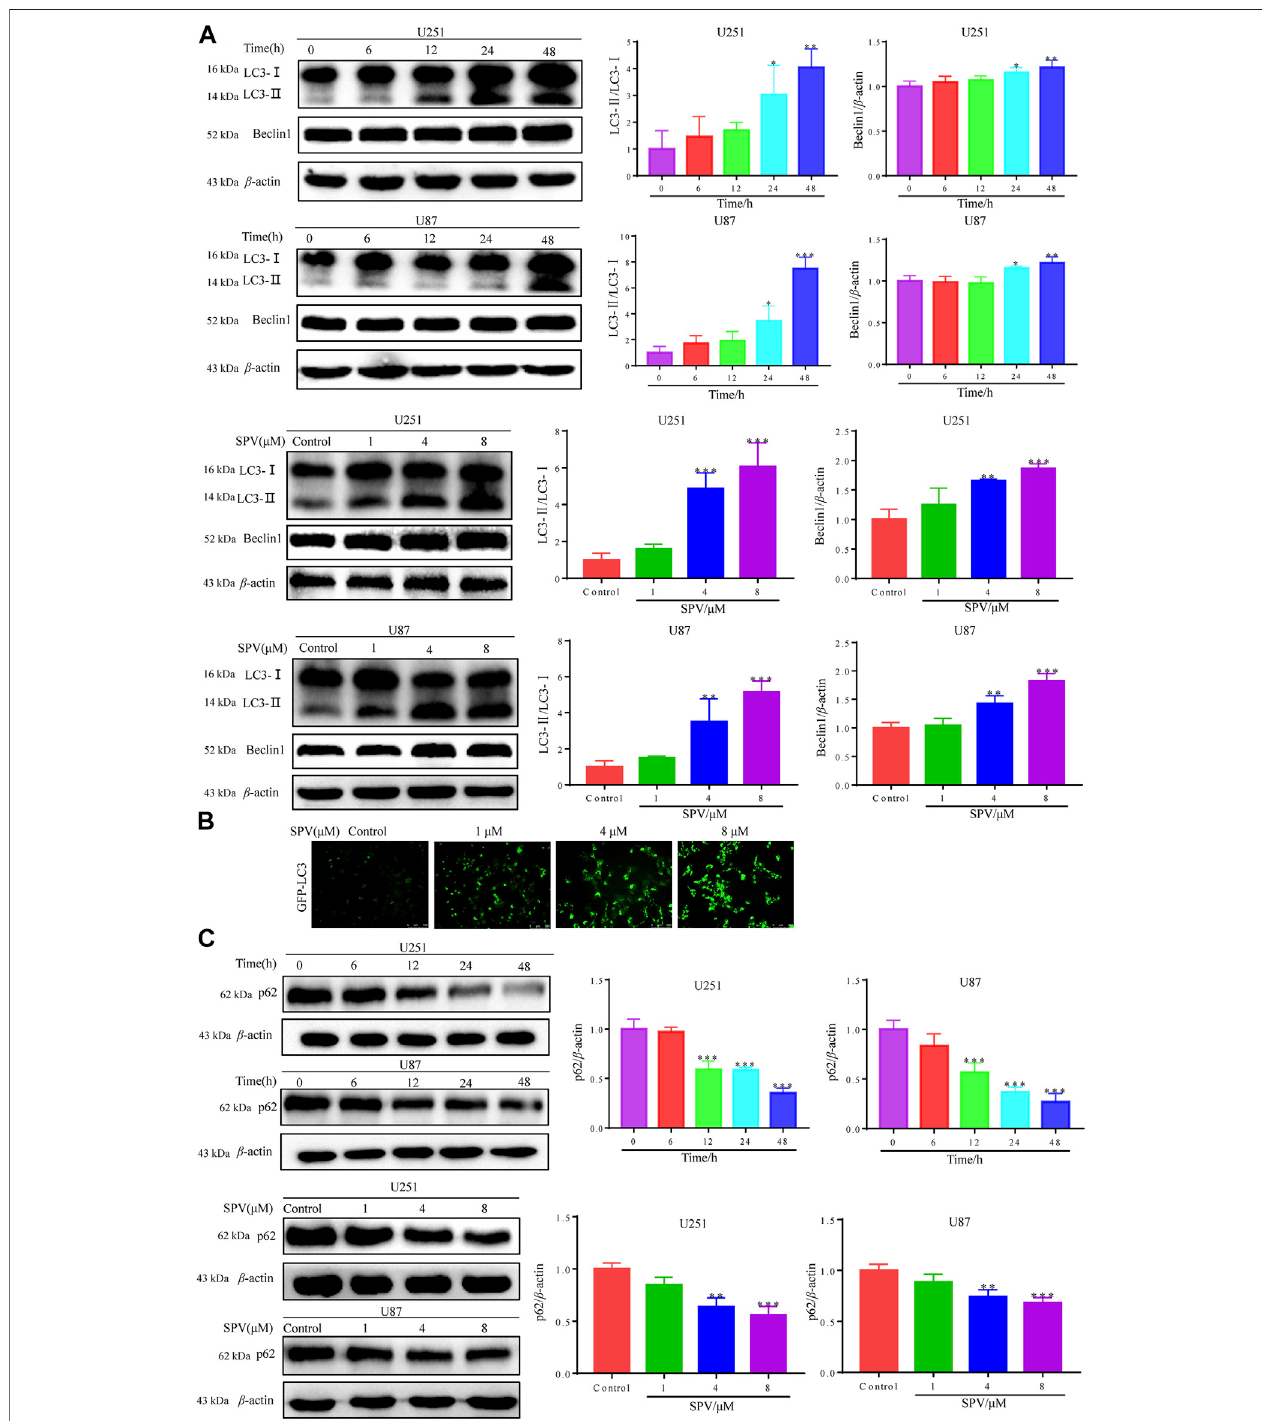
Figure 5 | Sempervirine triggered autophagy in glioma cells. (A) Cells were incubated with sempervirine (4 μ M) for different durations or treated with various concentrations (0, 1, 4 and 8 μ M) of sempervirine for 48 h. Western blotting for autophagy-associated protein LC3 and Beclin-1. (B) LC3 puncta formation was measuredbyimmuno fl uorescenceanalysisofU251cellstreatedwithvariousconcentrations(0,1,4and8 μ M)ofsempervirinefor48 h.Theimageswerecapturedusing a microscope. Scale bars (cid:2) 100 μ m. (C) The autophagy-related proteins p62 was determined by Western blotting. Data are presented as the Mean ± SD ( n (cid:2) 3). * p < 0.05, ** p < 0.01 and *** p < 0.001 compared with the control group.